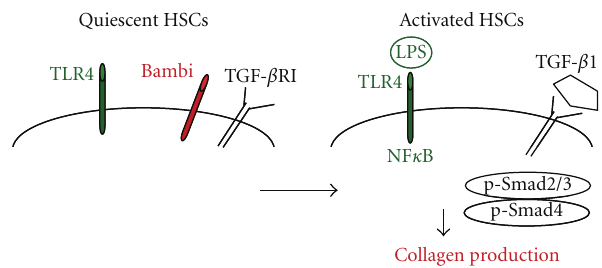
Figure 5: Activation of Hepatic Stellate cells following TLR4 and TGF β Receptor cross-talk. In aHSCS, Bambi blocks TGF β R activation. TLR4 activation by LPS downregulates BAMBI, so that TGF β 1 now induces signal transductions of phosphorylated Smad2/3 and activation of collagen Type I production in